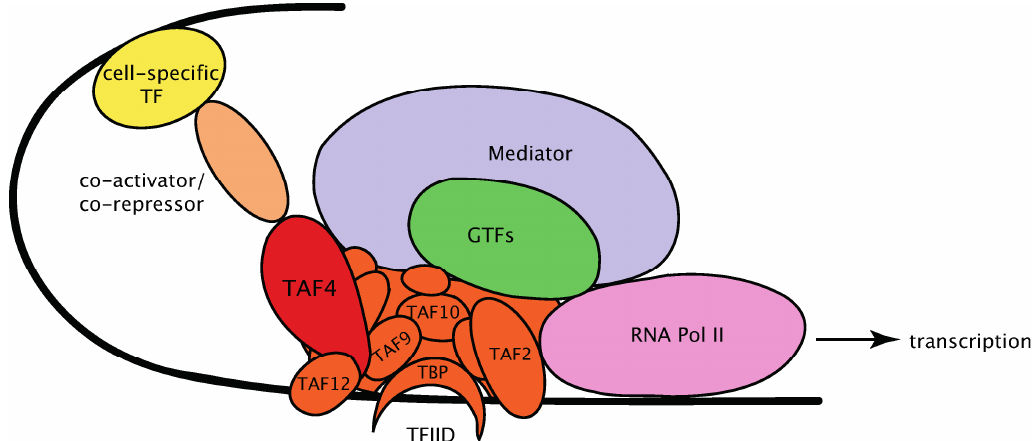
Figure 1. Multi-subunit tissue-specific RNA Pol II preinitiation complex (PIC) at the site of transcription. The main components of basal transcription preinitiation machinery (RNA Pol II (purple), GTFs (green), and Mediator (blue)) are presented. The tentative placement of some TBP-associated factors (TAF subunits) in the canonical TFIID complex (orange) is shown. TAF4 is specifically highlighted in brown. The co-activators/co-repressors (light brown) bridge upstream DNA-bound cell-specific transcription factors (yellow) with transcription machinery. It should be noted that various PIC complexes with different subunit compositions and sequence variation (isoforms) might be present, thus further diversifying PIC architecture beyond the example shown in this figure. TF, transcription factor; TBP, TATA box-binding protein; GTFs, general transcription